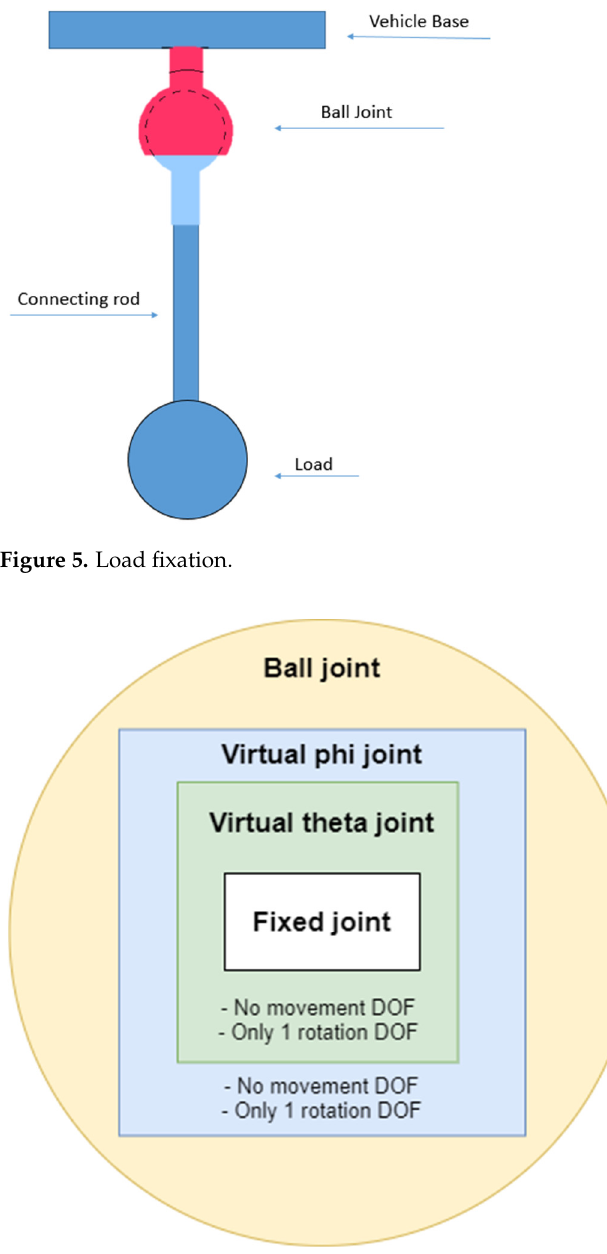
Figure 7. RVIZ display of the quadrotor with the suspended load . 4.2. Gazebo Implementation The Gazebo platform relies on an XML-based file format named SDF, which stands for Simulation Description Format—this is either written directly or generated from a scripted format under the name URDF (Universal Robot Description Format), or from macro format under the name XACRO. These formats ease the building of complex robots as they rely on defining the main components of the robots and connecting them through joints and links. Complex robotics rely mainly on templates generated from the XACRO